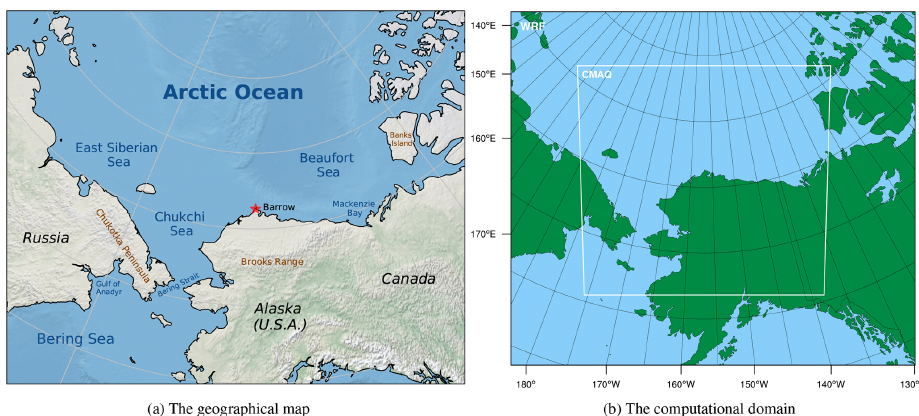
Figure 1. The geographical map of the research area and the computational domain used in WRF and CMAQ. The red asterisk in the figure denotes the location of Barrow. Table 1. Configurations of WRF and CMAQ in the present